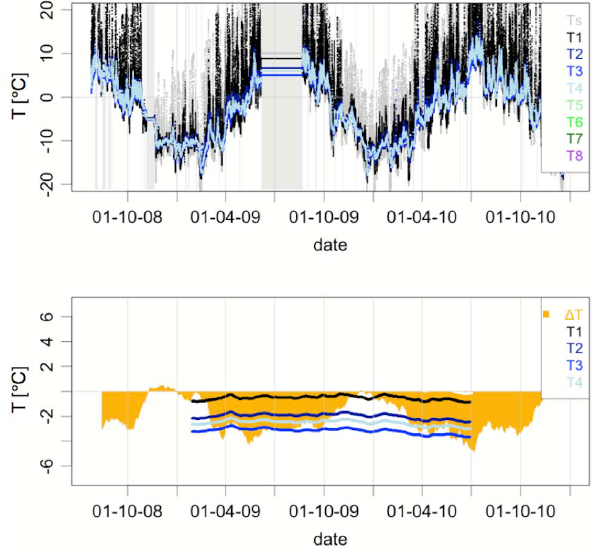
Fig. 11. Time series of mh01 with measured temperatures (top) and the temperature difference 1 T averaged over 30 days as well as MATs (bottom). Mh01 is a cleft at a location with intense irradia- tion.